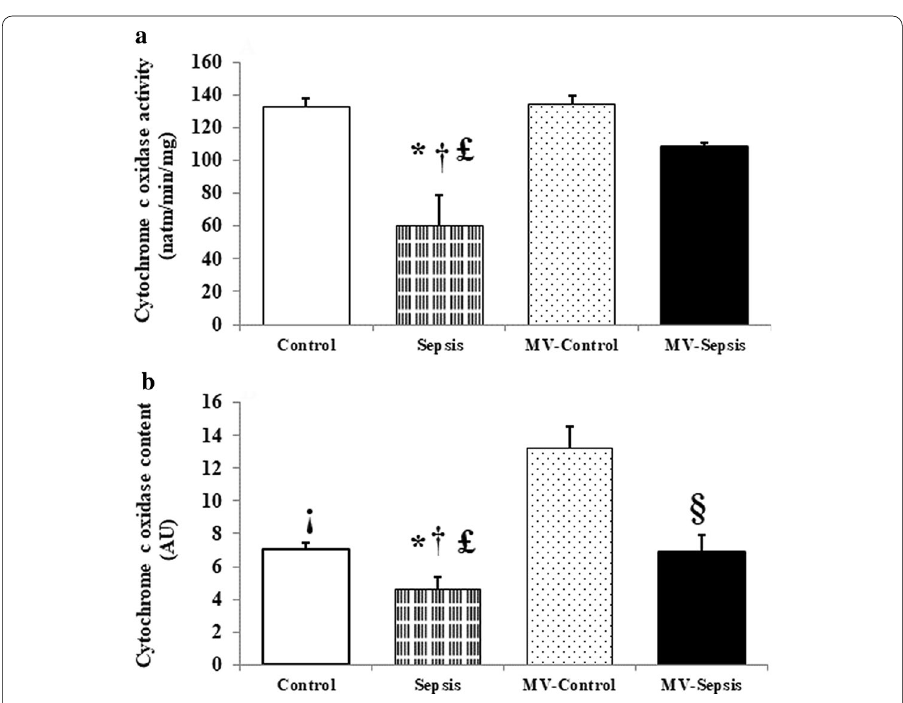
Fig. 3 Cytochrome c oxidase activity and subunit 1 content. The maximal activity of cytochrome c oxidase ( a ) and representative western blot of cytochrome c oxidase subunit 1 ( b ). Cytochrome c oxidase